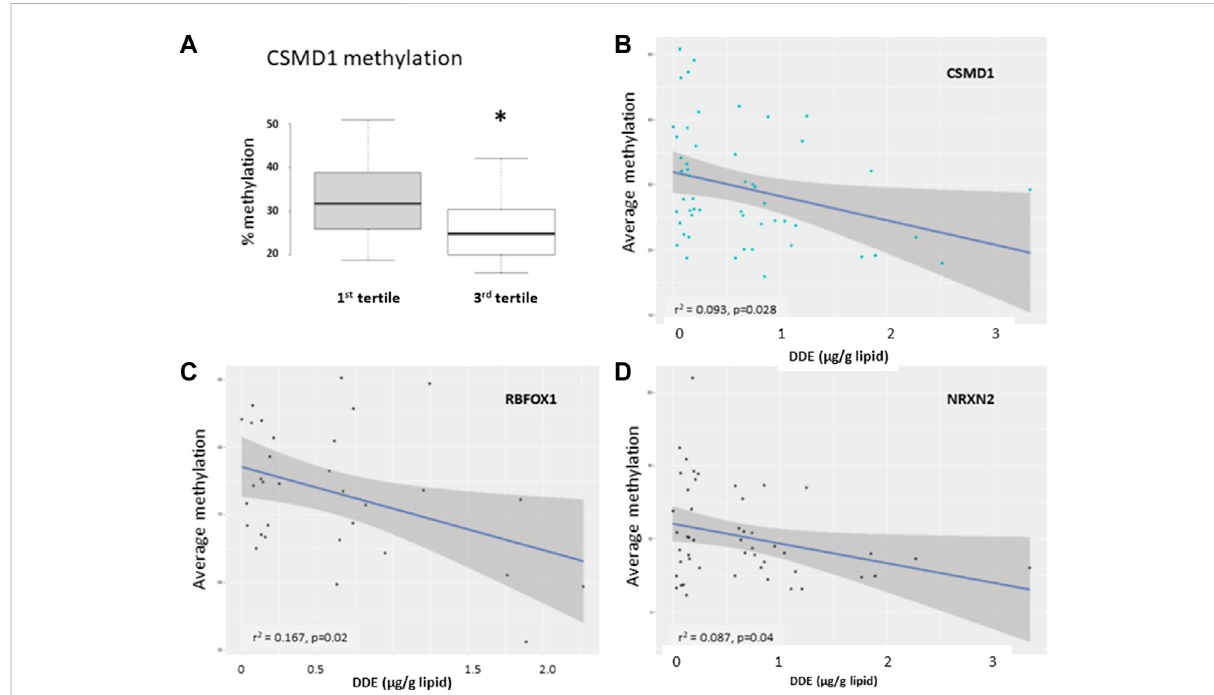
FIGURE 9 Results of pyrosequencing analyses of DMRs associated with CSMD1 (A,B) , RBFOX1 (C) , and NRXN2 (D) . The box plot (A) shows differential methylationatasingleCpGsitein CSMD1 whilethegraphsshowtheaveragemethylationasafunctionofDDEserumconcentration( μ g/gmlipid)for CSMD1 , RBFOX1 (10sites,discoverysetonly),and NRXN2 (7sites,allsamplesinbothdiscoveryandvalidationsets).R-squared(r 2 )and p -valuesforthe correlation curves are shown.